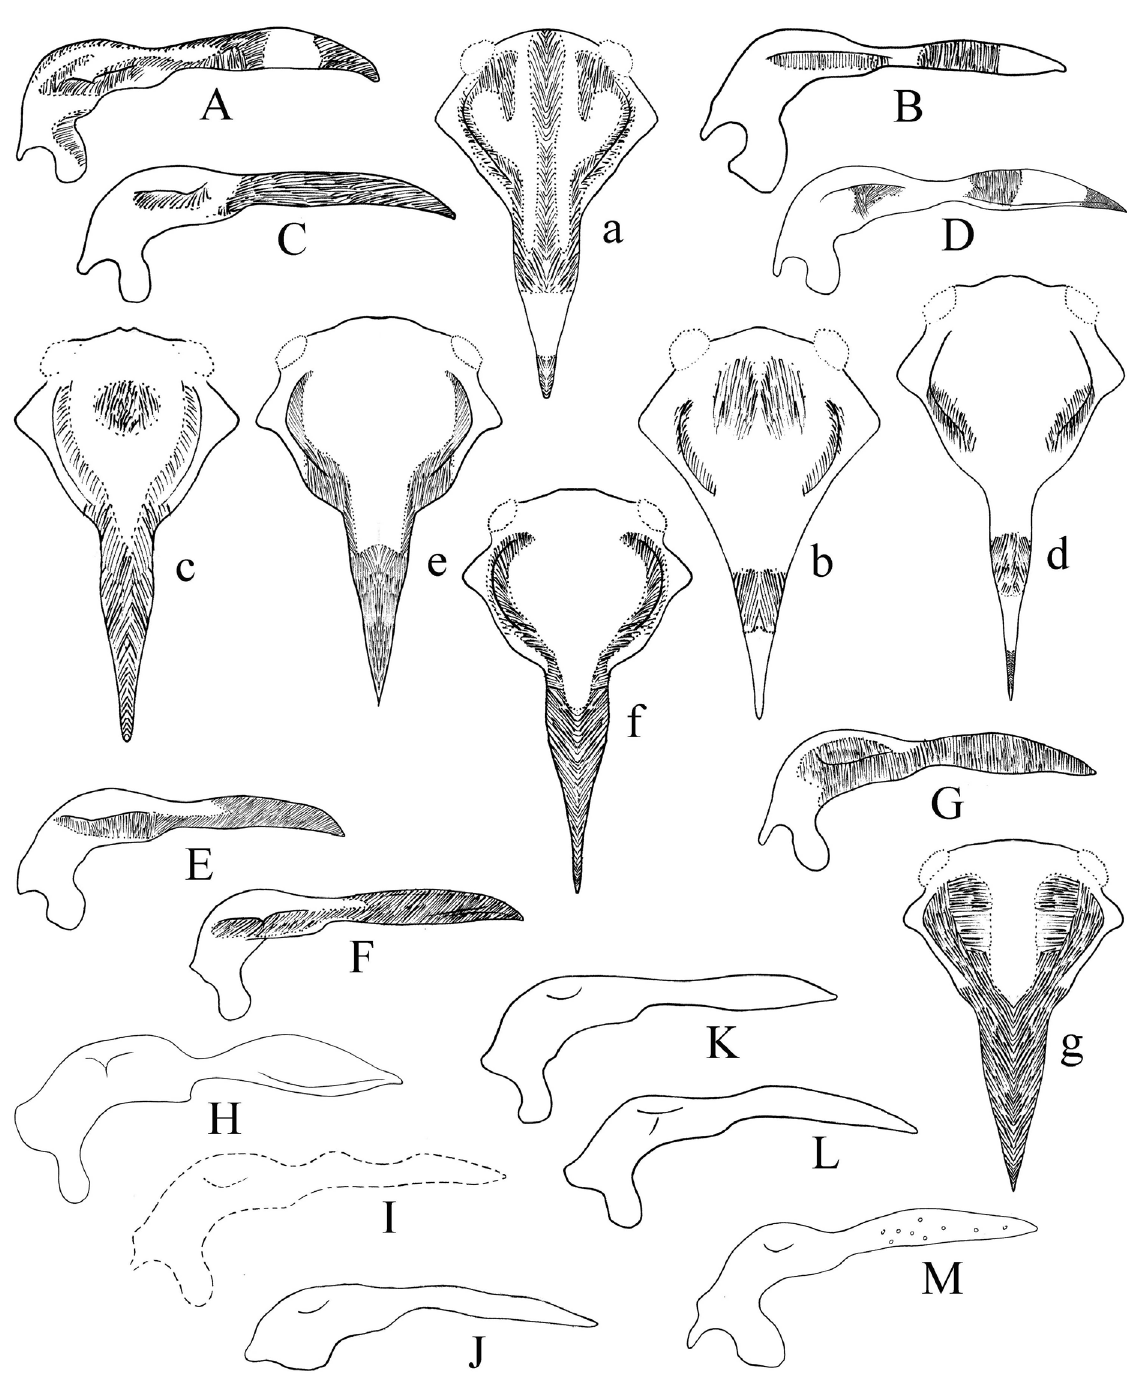
Fig. 8. Pronotum of 13 species of genus Machaerotypus Uhler, 1896. A–M . Lateral view. a–g . Dorsal